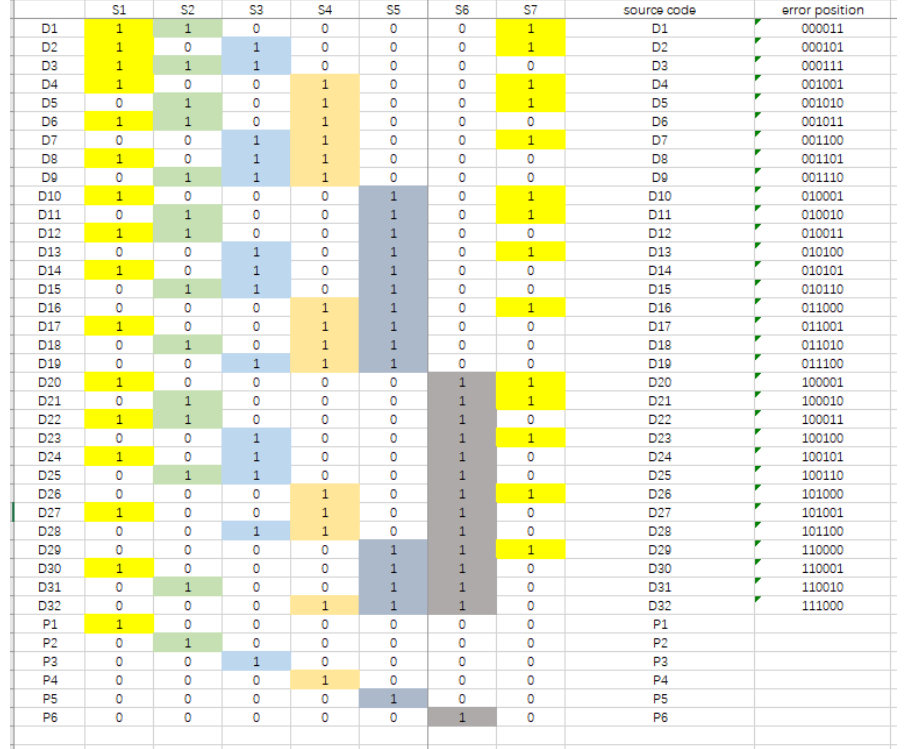
Figure 4. Improved SECDED code encoding and verification scheme.